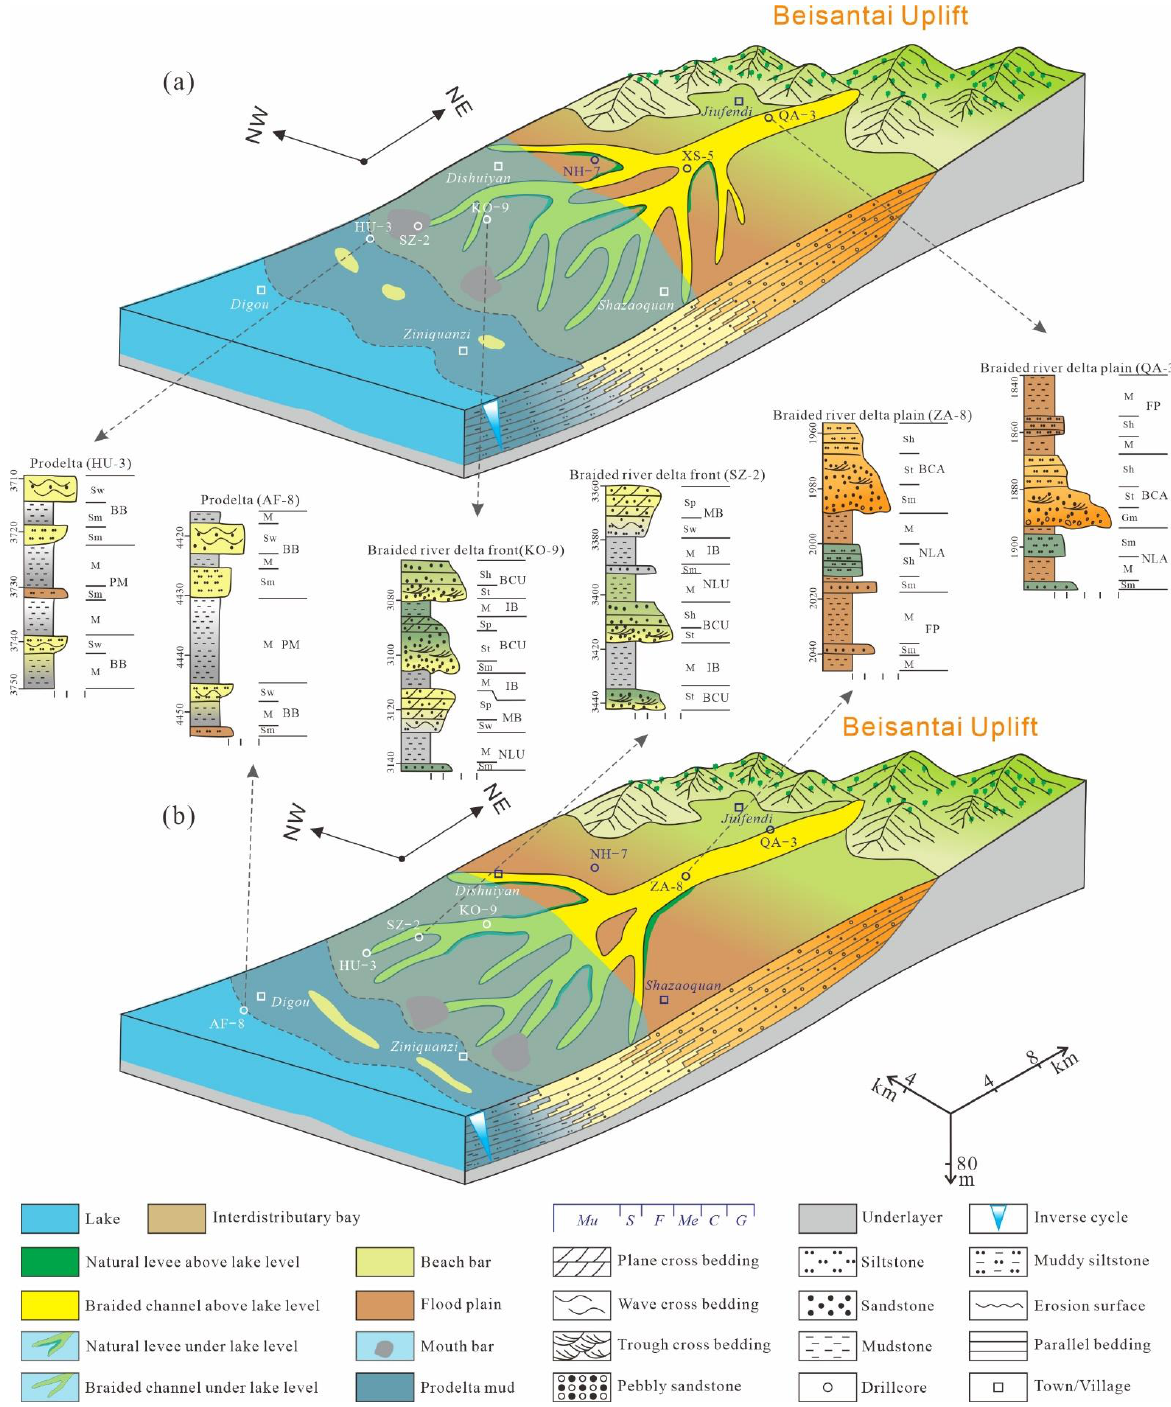
Figure 10. Depositional model of the braided river delta of the Jiucaiyuan Formation in the Beisantai Uplift. ( a ) Member I. ( b ) Member II. BB: beach bar; BCA: braided channel above lake level; BCU: braided channel under lake level; FP: flood plain; Gm: massive bedded gravel; IB: interdistributary bay; M: massive bedded mudstone; MB: mouth bar; NLA: natural levee above lake level; NLU: natural levee under lake level; PM: prodelta mud; Sh: parallel bedded siltstone; Sm: massive bedded gravel; Sp: plane bedded sandstone; St: trough bedded sandstone; and Sw: wavy bedded sandstone. Mu: mudstone; S: siltstone; F: fine-grained sandstone; Me: medium-grained sandstone; C: coarse-grained sandstone; and G: